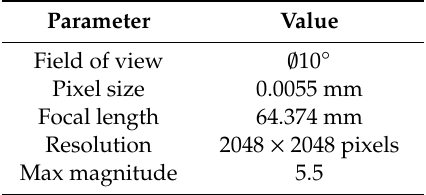
Table 1. Parameters of the Simulation Program.